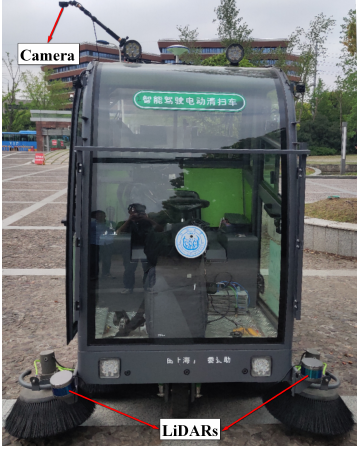
Figure 4. The intelligent sweeper of Tongji